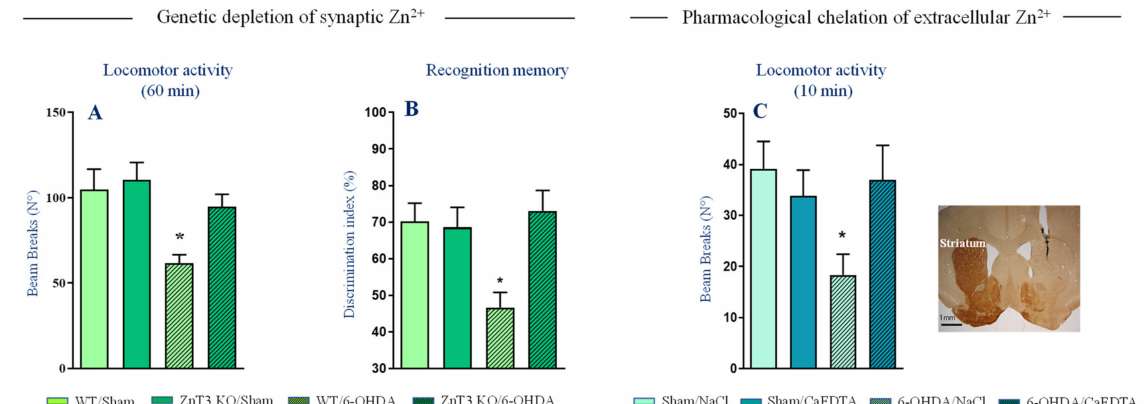
Figure 3. Genetic elimination of vesicular Zn 2+ and intrastriatal chelation of extracellular Zn 2+ improve behavioral deficits of 6-OHDA lesions. ( A ) Locomotor activity of ZnT3 KO and WT mice subjected to partial unilateral intrastriatal 6-OHDA lesion ( n = 7–8 per genotype). ( B ) Recognition memory of ZnT3 KO and WT mice subjected to partial bilateral intrastriatal 6-OHDA lesion ( n = 7–10 per genotype). Corresponding control groups, Sham/ZnT3 KO and Sham/WT mice received intrastriatal injection of vehicle ( n = 7–12 per genotype). ( C ) Locomotor activity of BL6J mice subjected to full unilateral intrastriatal 6-OHDA lesion. Mice received CaEDTA (Sham/CaEDTA and 6-OHDA/CAEDTA, n = 7 per treatment) or vehicle (Sham/NaCl and 6-OHDA/NaCl, n = 6–7 per treatment) injection into dorsal striatum. Representative coronal section showing a complete loss of TH-positive fibers and injector needle placement in the dorsal striatum. Data expressed as mean ± SEM, * p < 0.05 vs. Sham/WT or Sham/NaCl group, Dunnett’s post-hoc test following a significant two-way ANOVA. Modified with permission from Sikora et al., (2020)